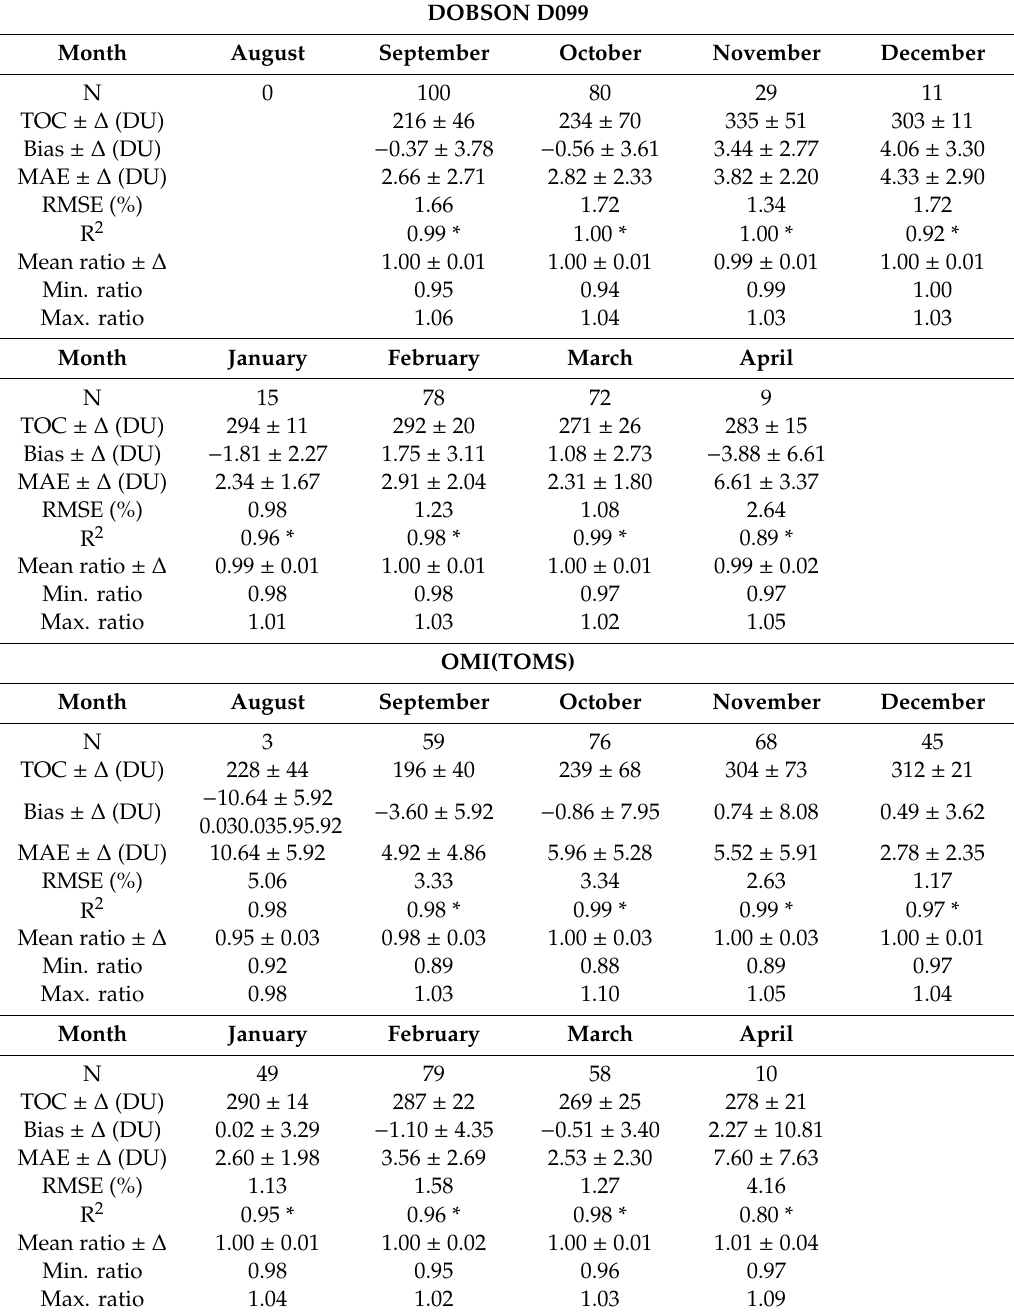
Table A4. Monthly statistics derived for individual data sources (asterisks indicate statistically significant ( α = 0.05)